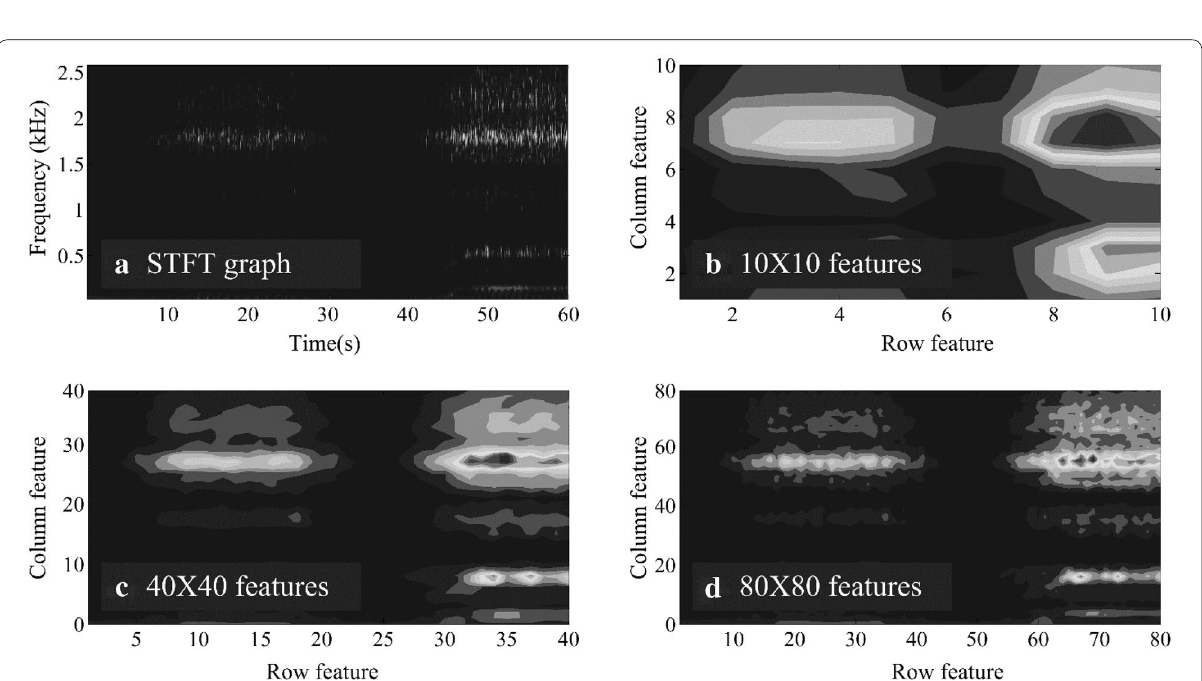
10 features; c 40 40 features; d 80 80 × × ×